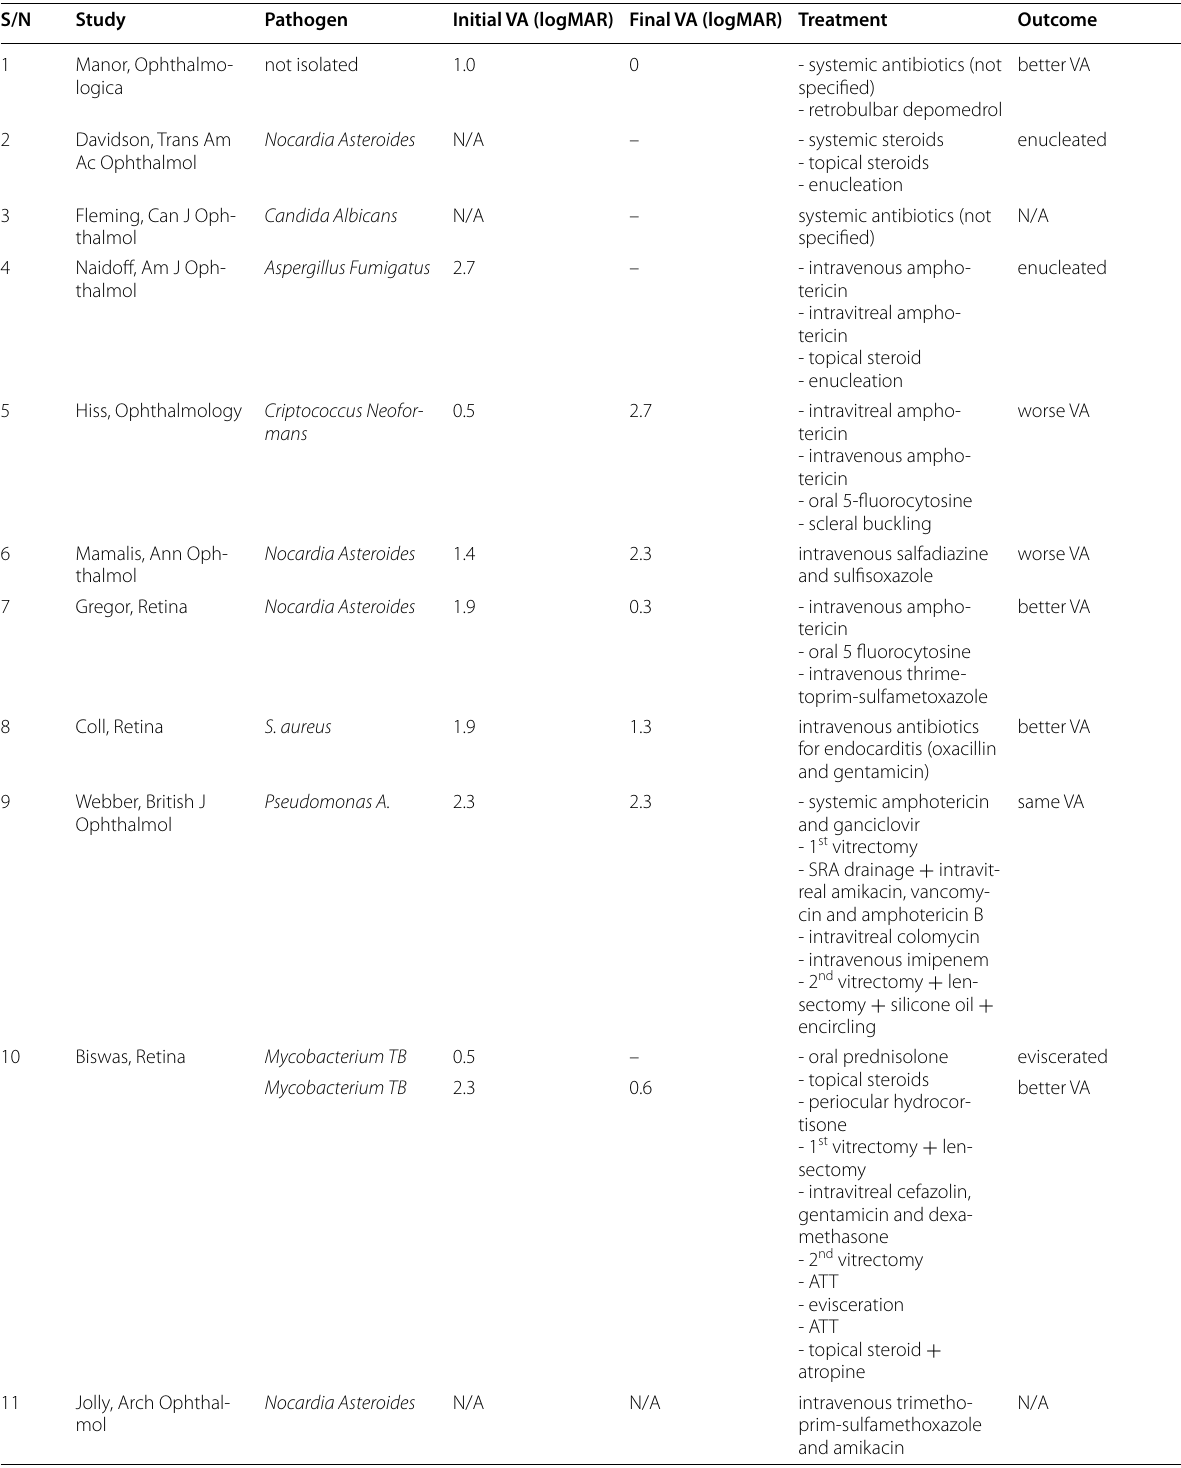
Table 4 Summary of initial and final visual acuity, treatment interventions and final outcomes of SRA with systemic foci S/N